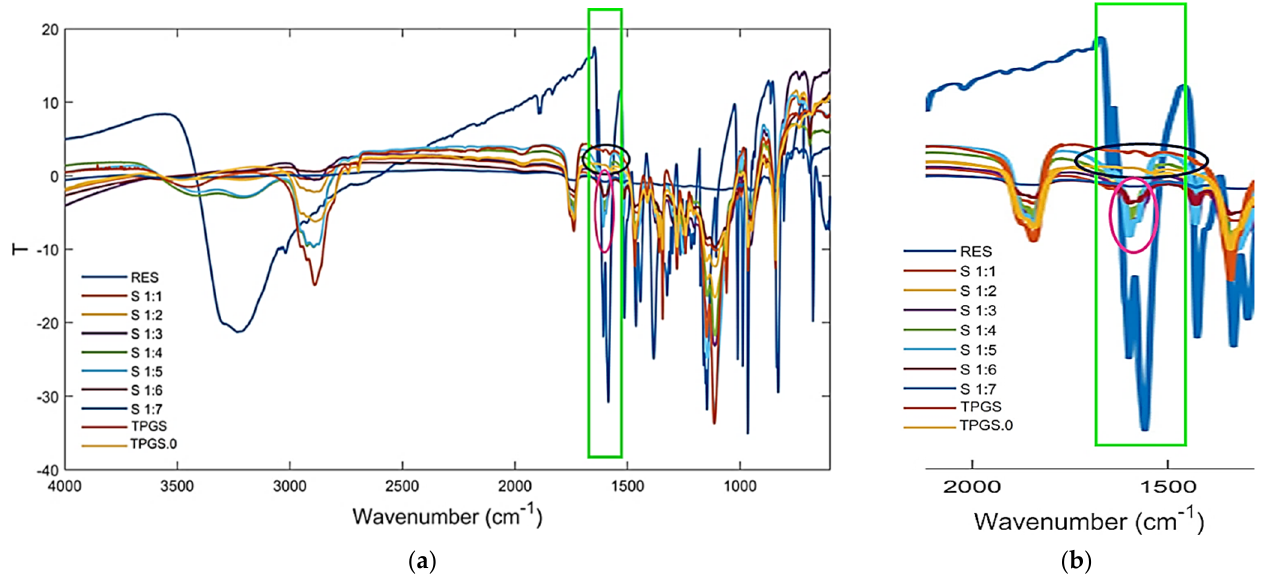
Figure 4. Fourier transform infrared spectroscopy (FTIR) spectra of RES, two different samples of TPGS and of the RES-TPGS formulations prepared ( a ); magnification of a significant spectral region ( b ).